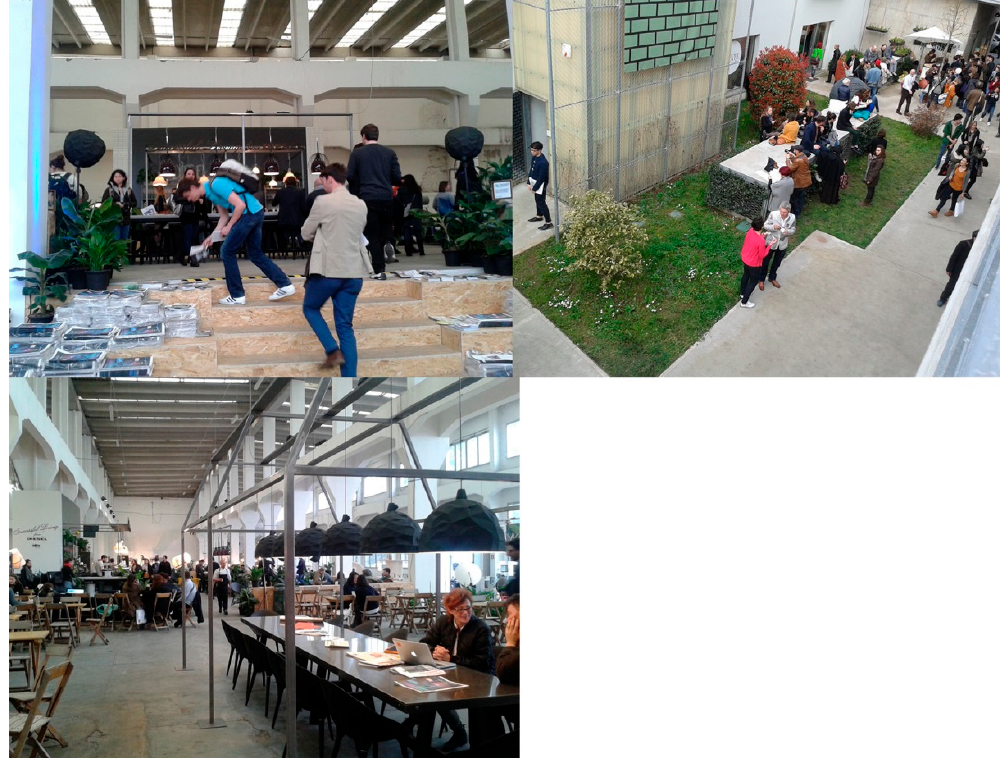
Figure 6. Activities offered by the CSs. Source: Lisa Astolfi (co-author)